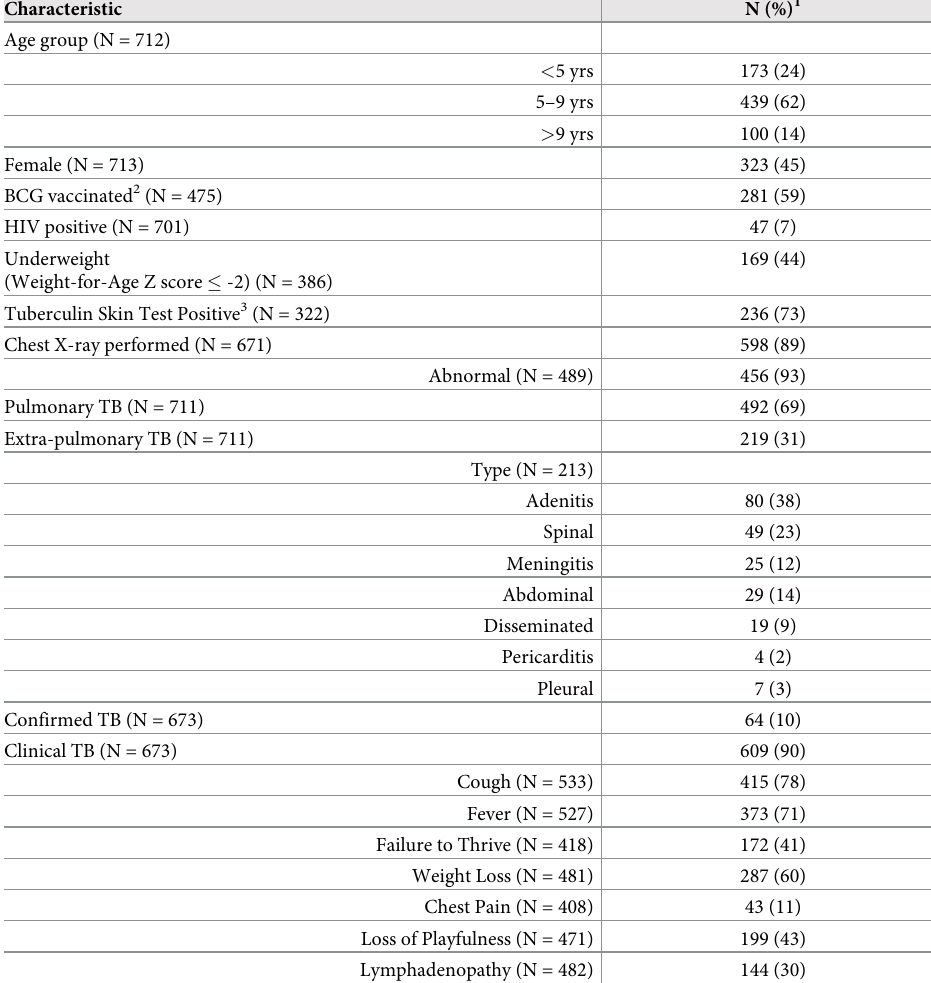
Table 1. Child tuberculosis cases at Mulago Hospital, Kampala, Uganda,